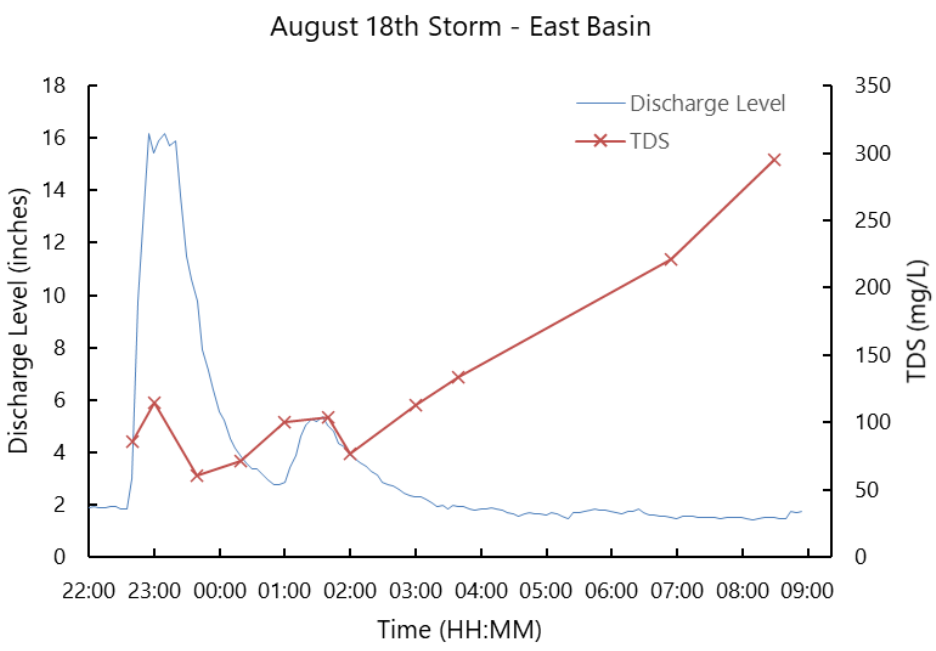
Figure 5. Discretely analyzed storm showing no evidence of first-flush effect for TDS at the East basin for the storm occurring on 18 August 2018. Blue line represents the hydrograph, and the orange line represents the TDS concentration.